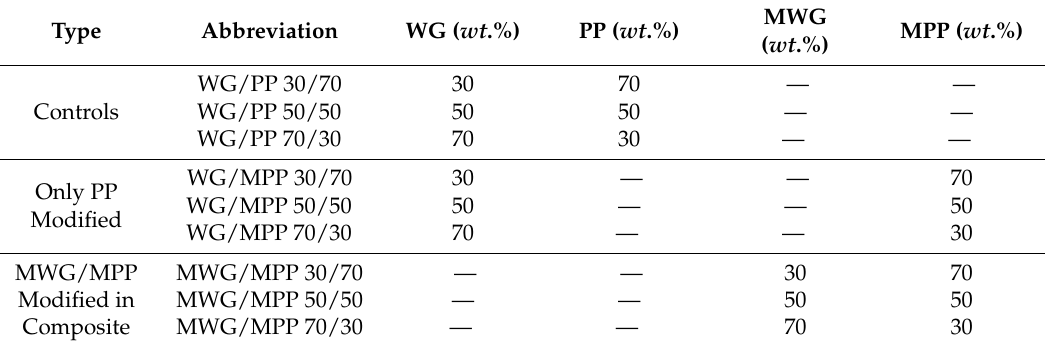
Table 1. Compositions of the blends of WG, PP, MWG and